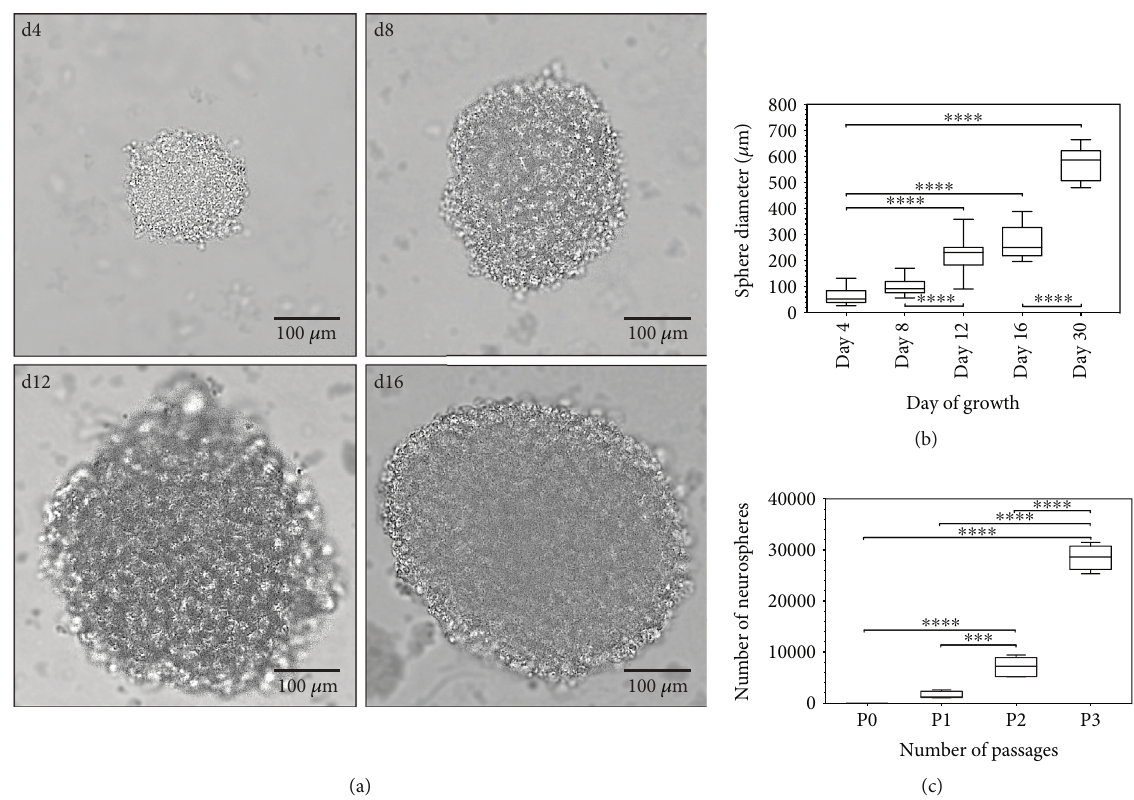
Figure 1: (a) Formation of primary neurospheres from neural stem cells of the postnatal day 6 rat IC in the course of time in free- fl oating cell cultures with NSC medium containing the growth factors EGF and bFGF (transmitted light microscopy). (b) Primary IC neurosphere diameters with time up to 30 days in NSC medium. There is a signi fi cant increase in size from day 4 onwards in culture. (c) Throughout 3 passages for a total of 90 days, the number of spheres at the end of the respective culture period increased signi fi cantly. Box plots show the median with the upper and lower quartiles, and whiskers mark the upper and lower maximum values; asterisks indicate the level of signi fi cance: ∗ p < 0 : 05 , ∗∗ p < 0 : 005 , ∗∗∗ p < 0 : 001 , and ∗∗∗∗ p < 0 : 0001 .